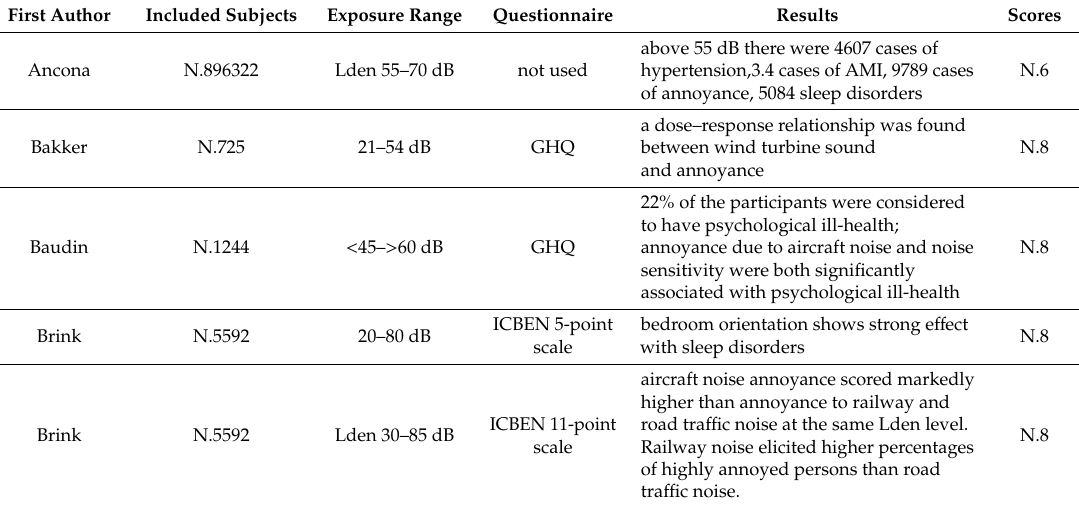
Table 4. Cross articles included in this review, in alphabetical order, with their relative